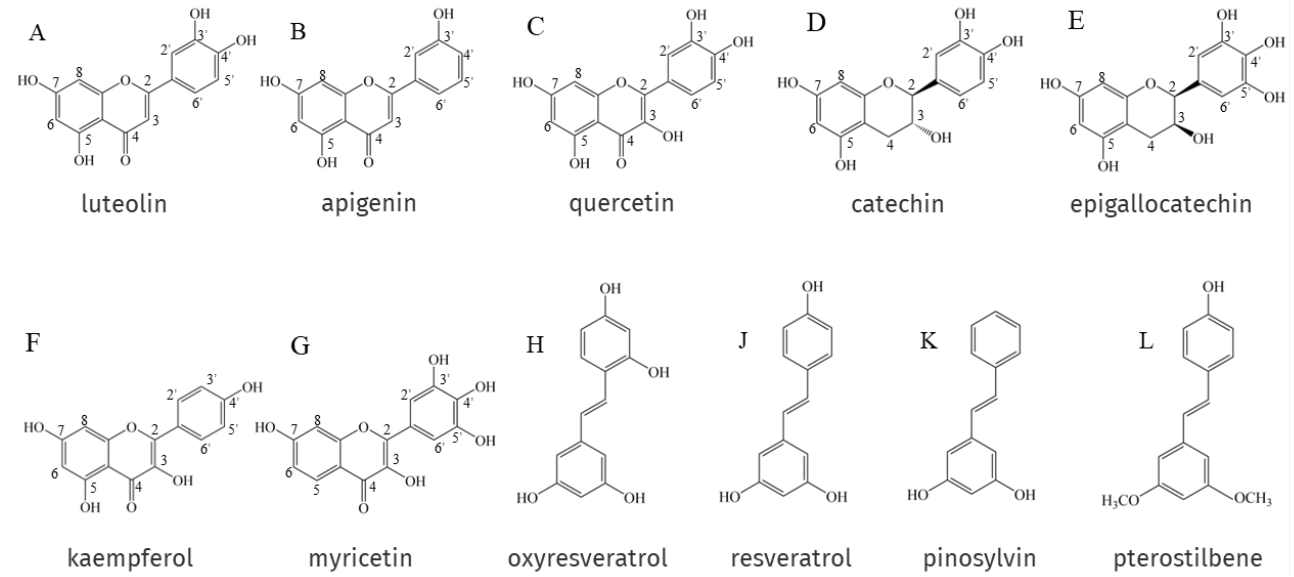
Figure 1. Structural formulae for EPs and NEPs as described in Section